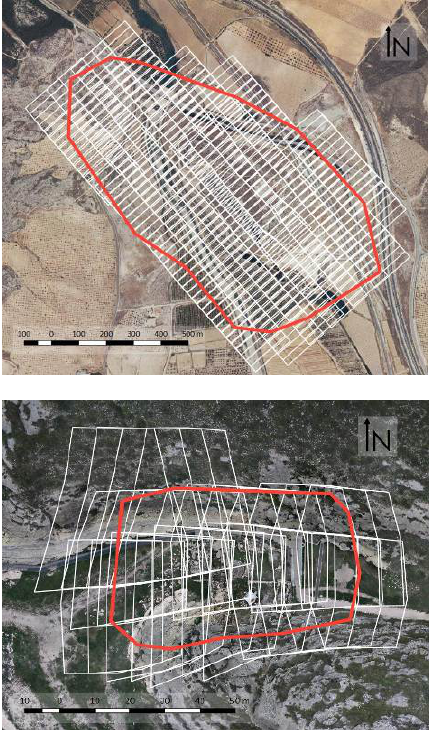
Figure 3. Images footprints projected over terrain for the 3 cm GSD flight (up) and the 1 cm GSD flight (down).